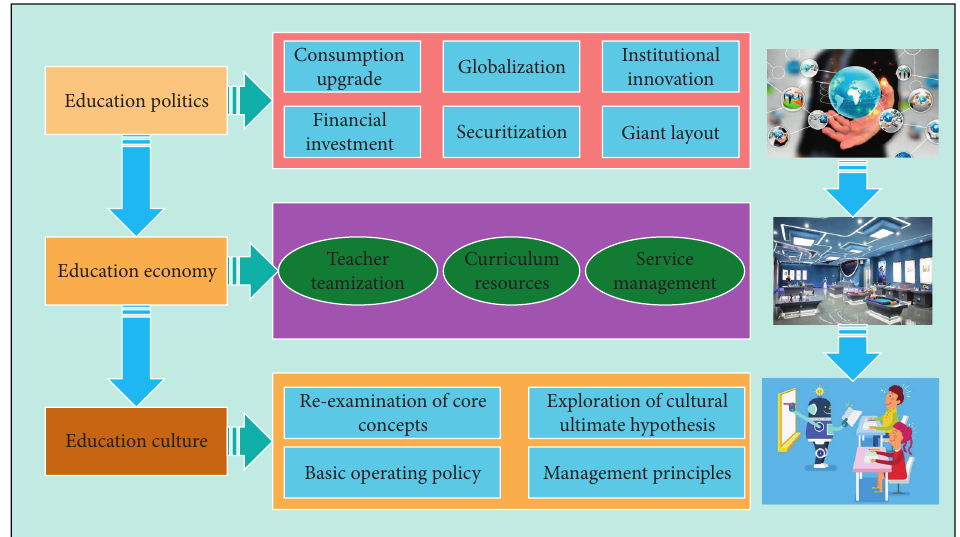
Figure 2: Music education information